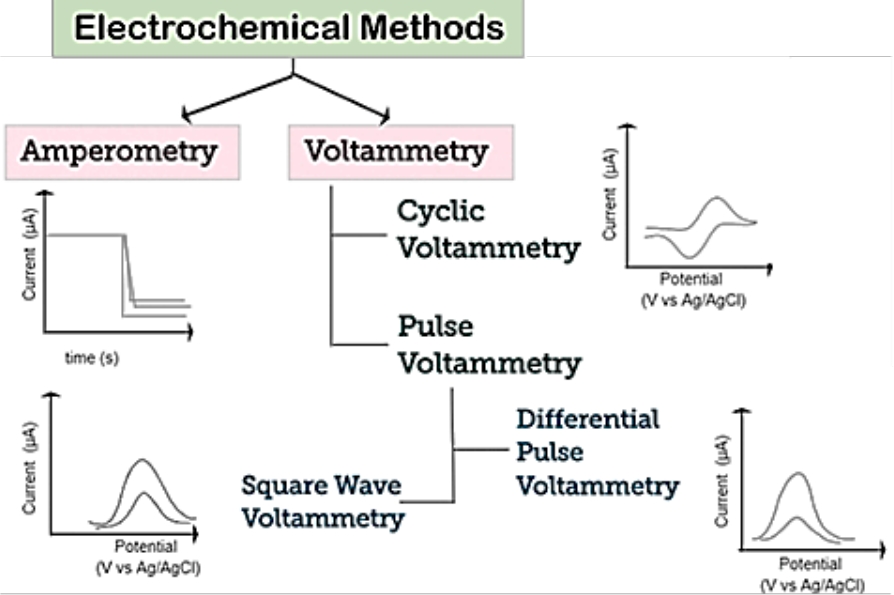
Figure 5. Schematization of electrochemical techniques used for detection of biomolecules. Adapted with permission from reference [56].